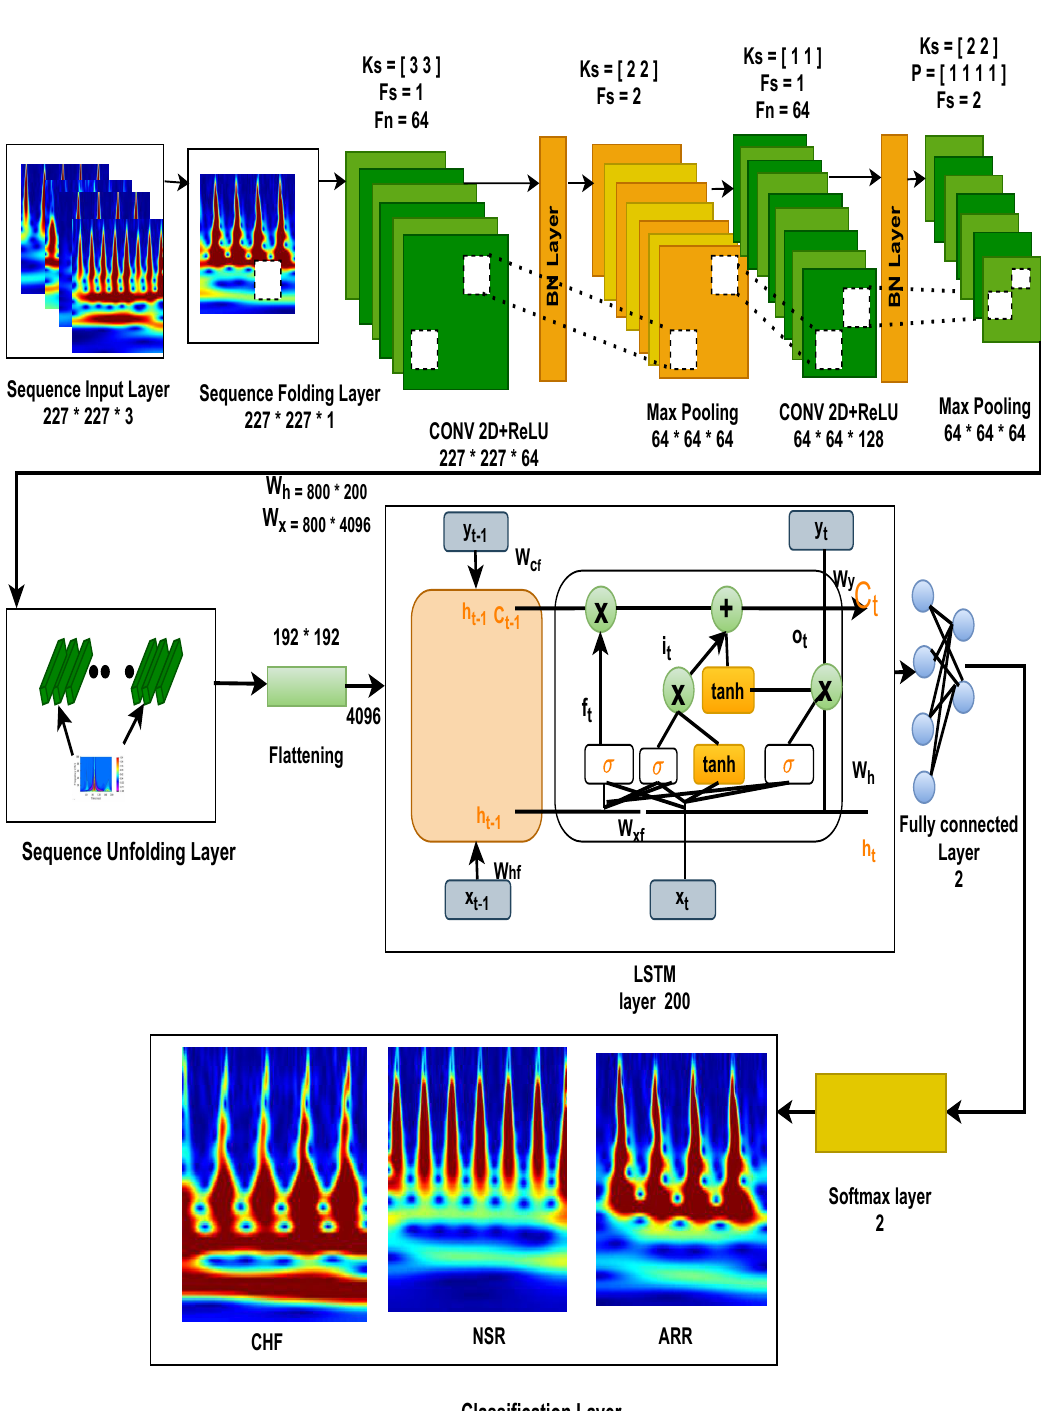
Figure 8. Representation of the internal architectural details of the proposed